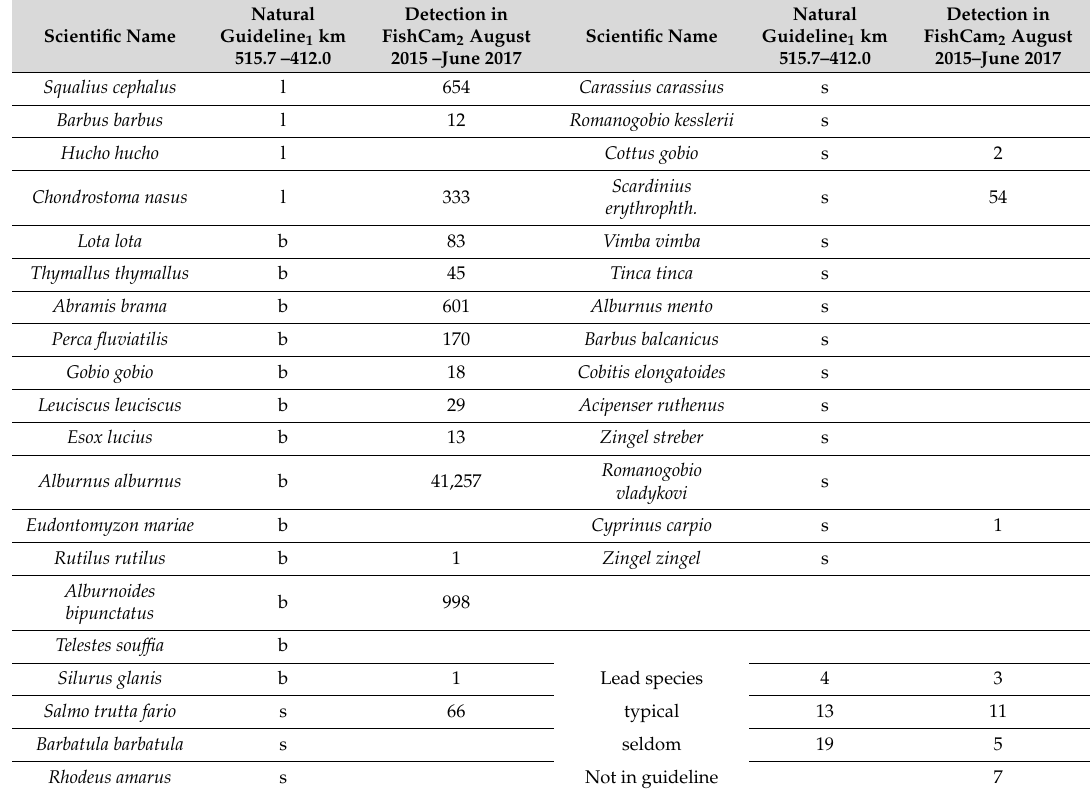
Table 3. Species and individuals detected by FishCam during their migration upwards.